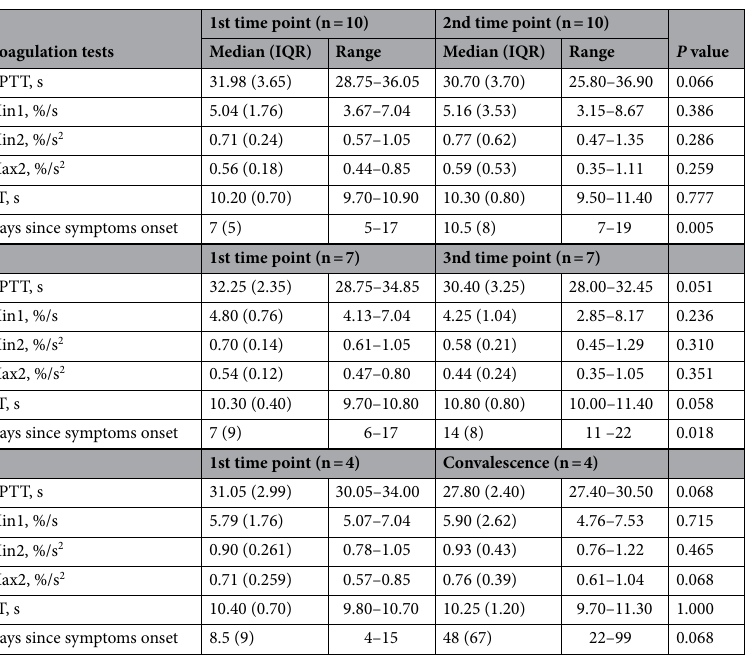
Table 2. Paired comparison analysis of coagulation data (PT, aPTT and aPTT-based clot waveform analysis profiles) of patients with mild COVID-19^. These are intra-individual comparison of their serial coagulation data. * No D-dimer and fibrinogen data presented as not more than 2 pairs of these results were available. ^ Mild COVID-19 defined as patients who did not require supplementary oxygen support throughout the course of